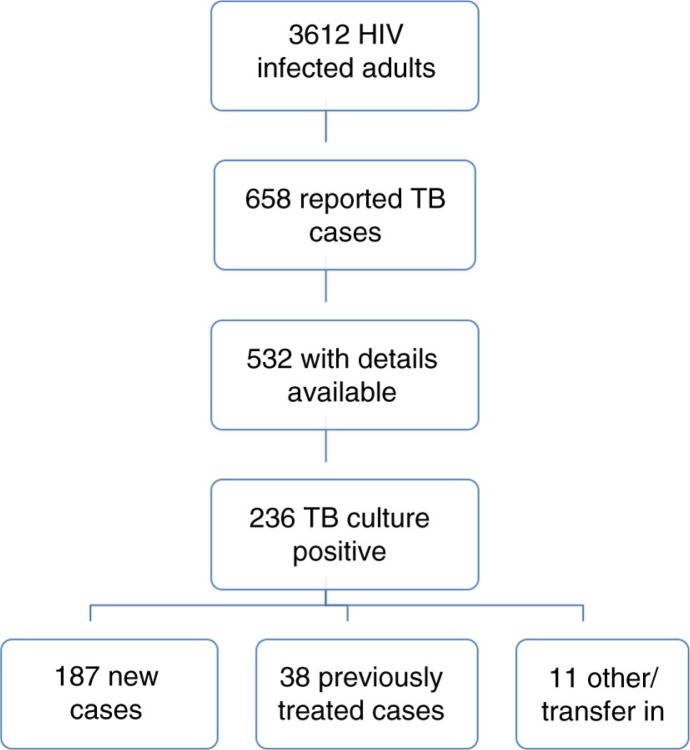
TB cases amongst HIV-infected patients.